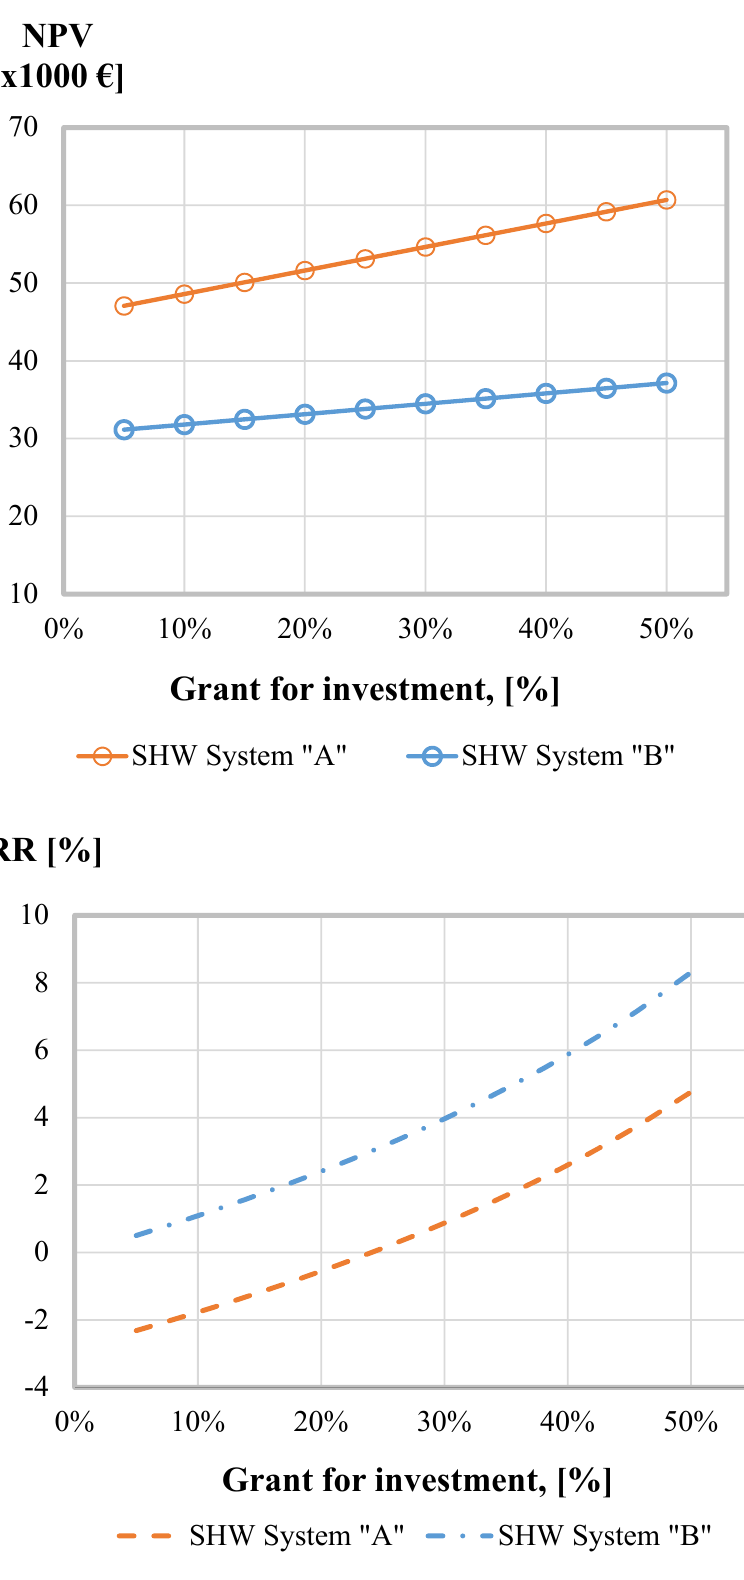
Figure 4. Influence of the grant covering part of the investment costs on Nominal Present Value (NPV) and Internal Rate of Return (IRR) of the SHW systems “A” and